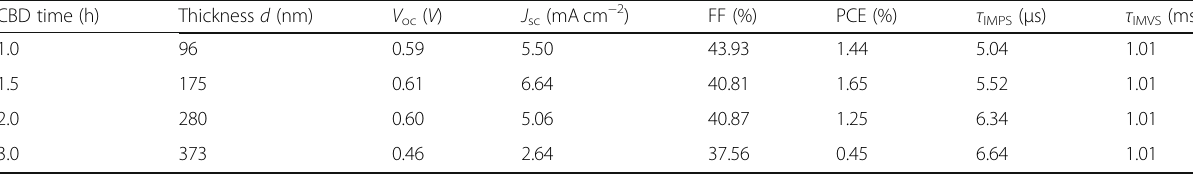
Table 1 Device performance of the TiO 2 /Sb 2 S 3 /P3HT n-i-p planar solar cells under AM 1.5 illumination of 100 mW/cm 2 CBD time (h) Thickness d (nm) V oc ( V